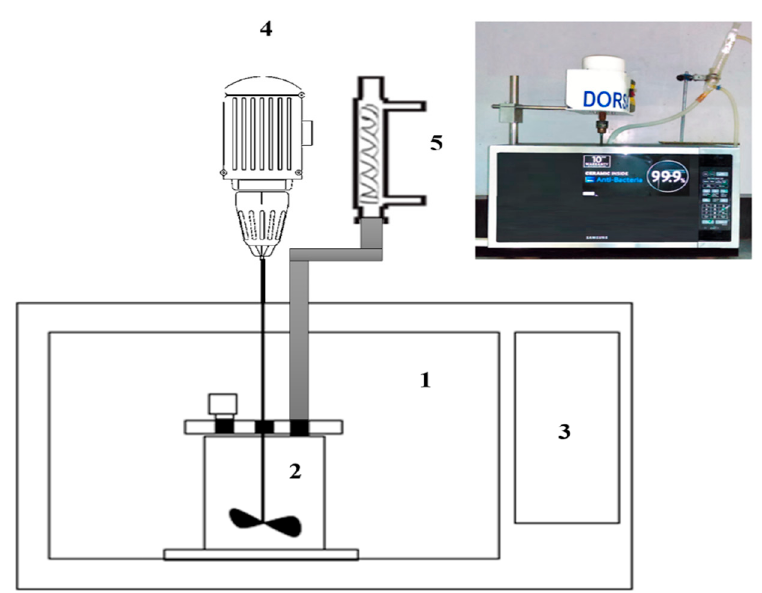
Figure 3. The microwave-leaching set-up ( 1 : microwave chamber; 2 : Teflon reactor; 3 : controller; 4 : mixer; 5 : condenser reflux).